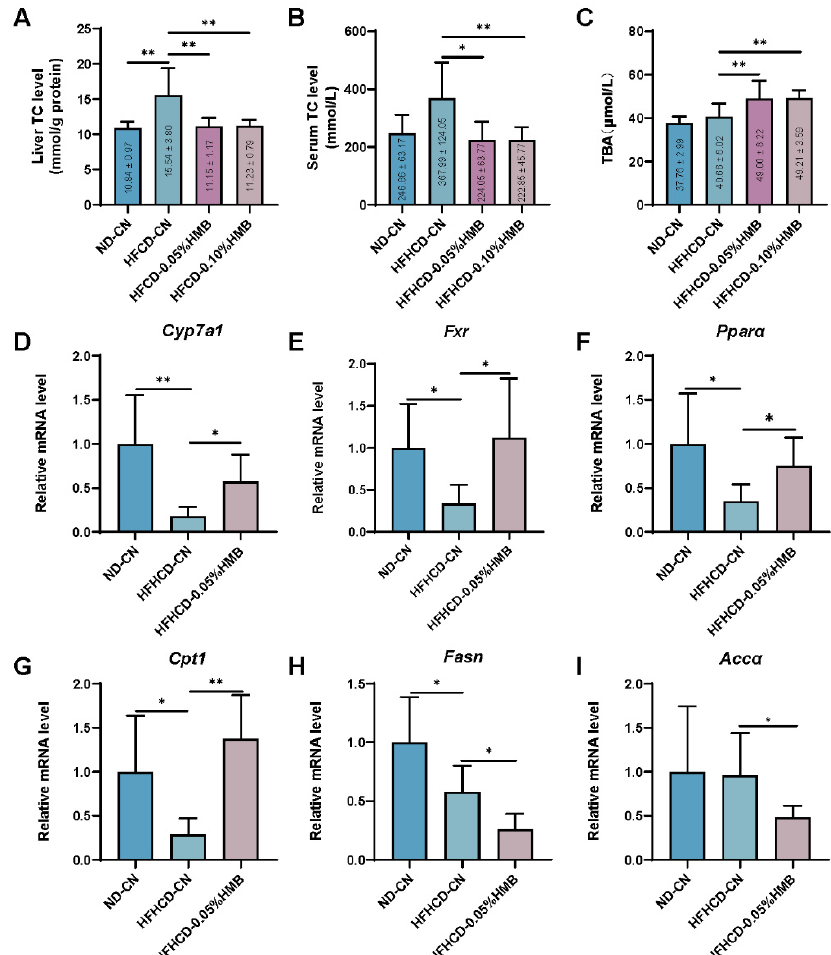
Figure 4. Effects of HMB on hepatic cholesterol and bile acid metabolism in HFHCD − challenged layers. ( A ) Liver total cholesterol (TC) content ( n = 8). ( B ) Serum total cholesterol (TC) content ( n = 6–8). ( C ) Liver total bile acid (TBA) content ( n = 8). ( D – I ) qRT-PCR analysis of the levels of Cyp7a1 , Fxr , Ppar α , Cpt1 , Fasn , and Acc α ( n = 5–6). All the results are shown as the means ± SDs; * p < 0.05, ** p < 0.01.